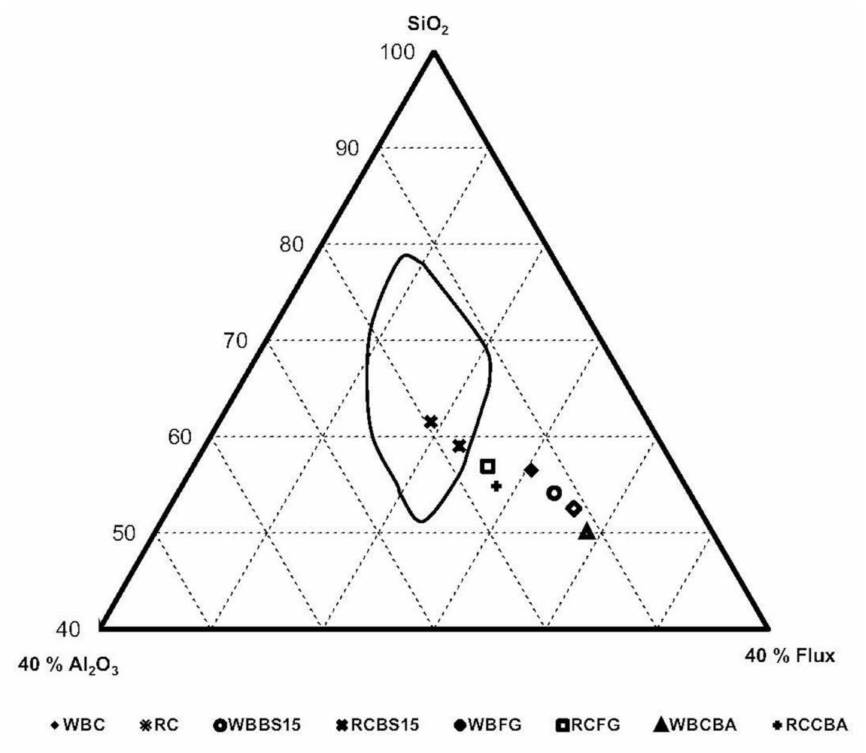
Figure 2. Representation of the aggregates studied in the Riley diagram